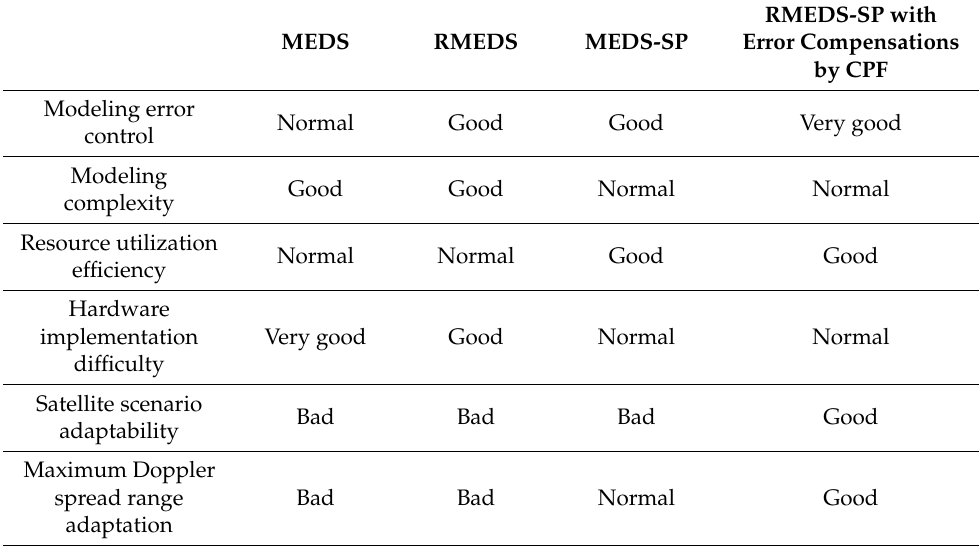
Table 4. Performance analysis of ACF and DPS in different